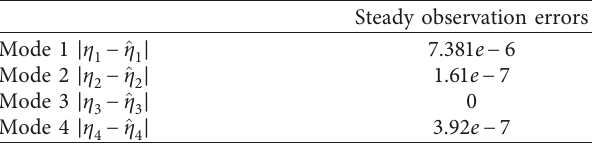
4 . Steady observation errors